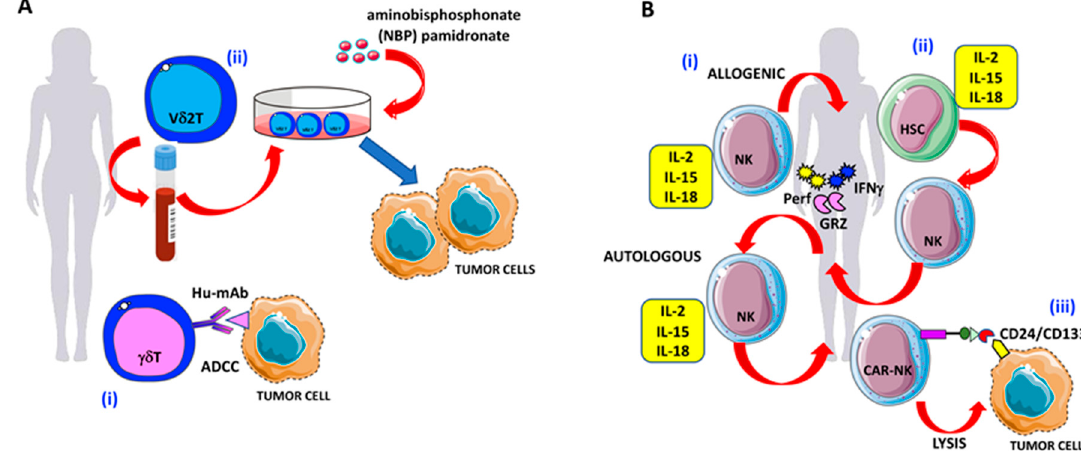
Figure 4. γδ T and NK cell-based therapies against OvCA cells: ( A ) Strategies to enhance γδ T cell antitumor activities in OvCA. (i) Triggering of γδ T cell-mediated antibody-dependent cellular cytotoxicity (ADCC) by specific hu-mAbs. (ii) Expansion of V δ 2 T cells derived from the peripheral blood in the presence of the amino-bisphosphonates (N-BPs) such as pamidronate to increase OvCA cell elimination. ( B ) Strategies to enhance NK cell antitumor activities in OvCA. (i) Adoptive transferred NK cells, primed with IL-2, IL-15, and IL-18 to increase antitumor activities against OvCA via the production of granzymes, perforin, and IFN γ . (ii) Generation of IFN γ -, granzyme-, and perforin-producing NK cells by the administration of cytokine cocktails (IL-2, IL-15, and IL-18) to bone marrow or peripheral blood or cord blood-derived hematopoietic stem cells (HSCs); (iii) CD24 / CD133 chimeric antigen receptor (CAR)-engineered NK cells with increased cytotoxic activity against CD24-positive OvCA cell lines (SKOV3 and OVCAR3).